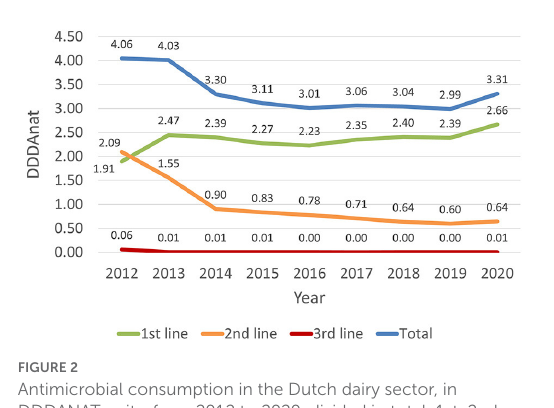
FIGURE2 Antimicrobial consumption in the Dutch dairy sector, in DDDANAT units, from 2012 to 2020, divided in total, 1st, 2nd and 3rd line